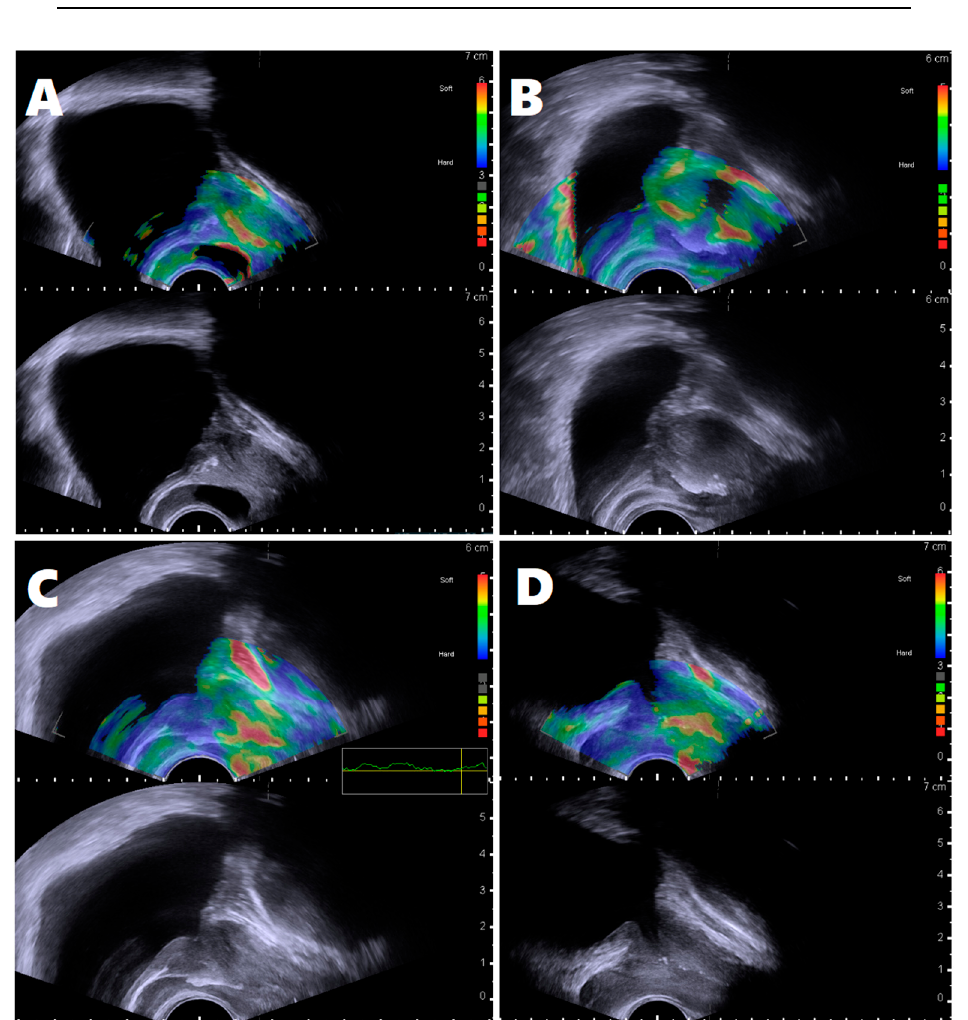
Figure 3. The reasons for inappropriate periurethral elastography. ( A ) midline cyst or periurethral degenerative cystic nodule; ( B ) prostate calcification including periurethral calcification; ( C ) inappropriate quality-scale bar which failed to reach a satisfactory quality scale; ( D ) lacking echotexture of bladder neck and proximal urethral course in B-mode.